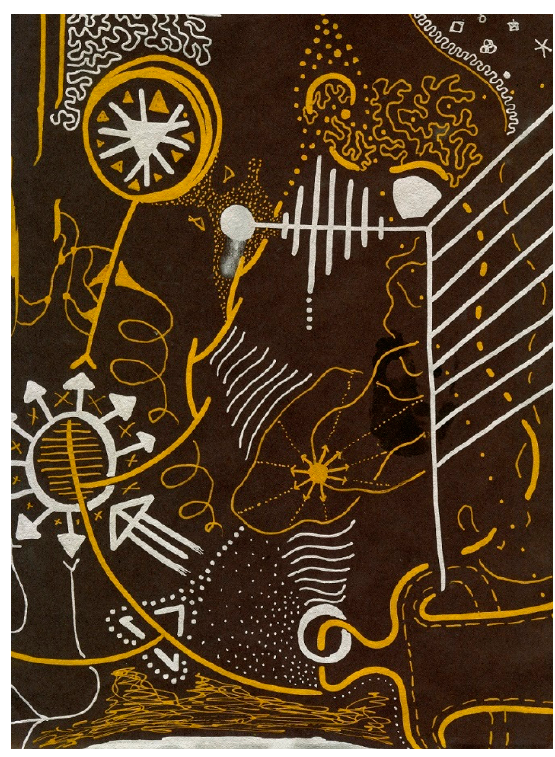
Figure A6. “Thinking.”. Silver and gold pens, black paper. Drawing made by authors. License: Creative Commons Attribution-NonCommercial 4.0 International.